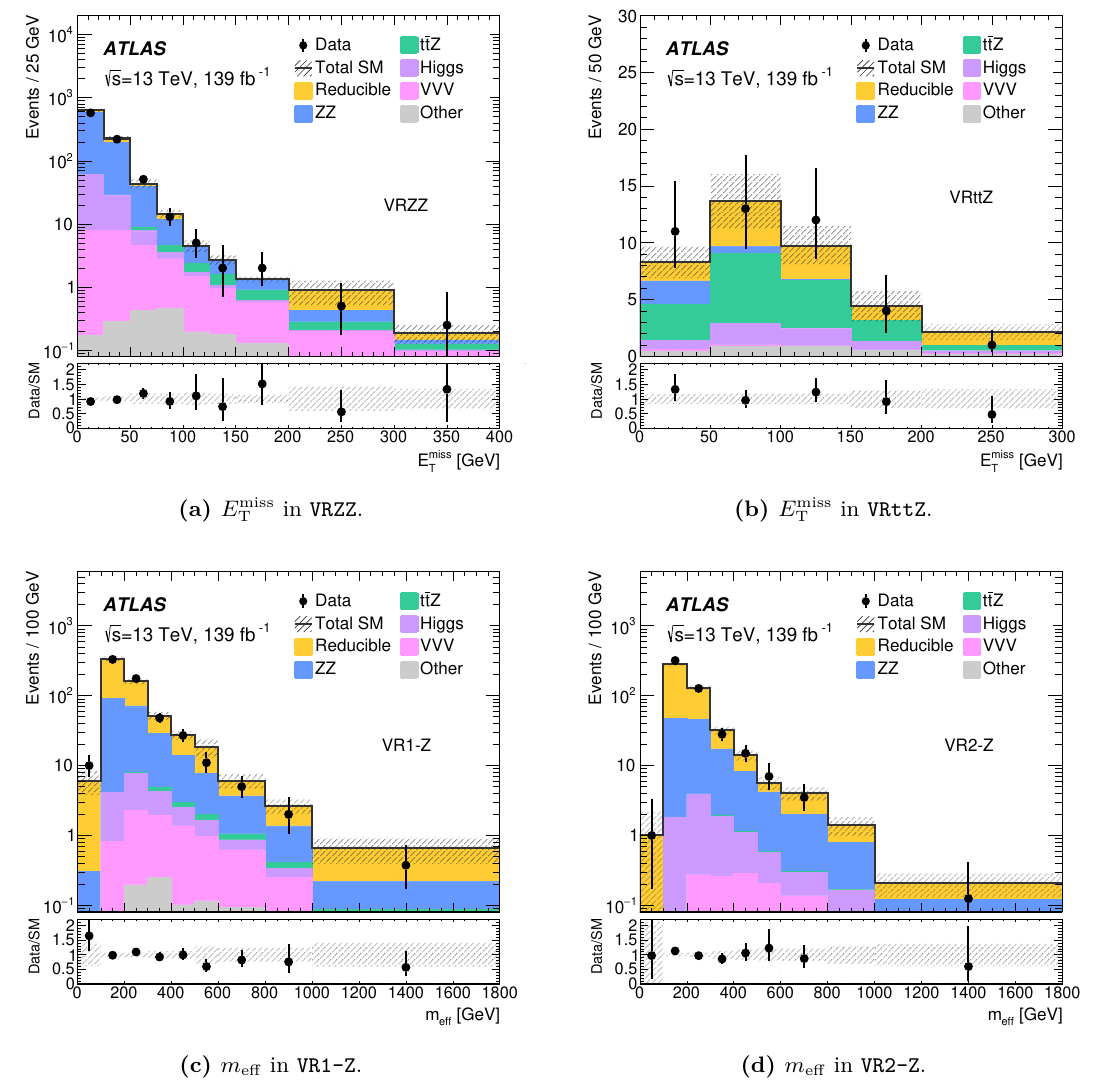
Figure 5. The distributions for data and the estimated SM backgrounds in the validation regions after the background-only fit, for the E miss in (a) VRZZ and (b) in VRttZ , and the m in (c) VR1-Z eff T and in (d) VR2-Z . “Other” is the sum of the tWZ , t ¯ tWW , t ¯ tZZ , t ¯ tWZ , t ¯ tWH , t ¯ tHH , t ¯ ttW , and t ¯ tt ¯ t backgrounds. The last bin includes the overflow. The lower panel shows the ratio of the observed data to the expected SM background yield in each bin. Both the statistical and systematic uncertainties in the SM background are included in the shaded